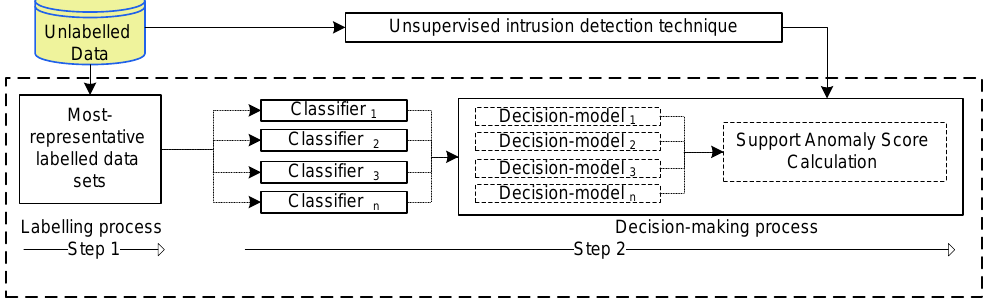
Figure 1. Overview of